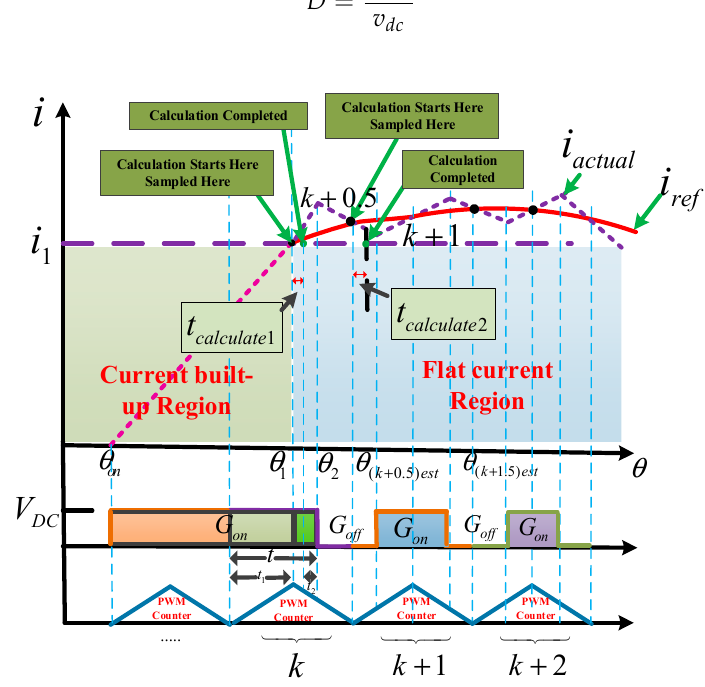
Figure 3. Duty ratio predicted at current build-up and flat flowing.